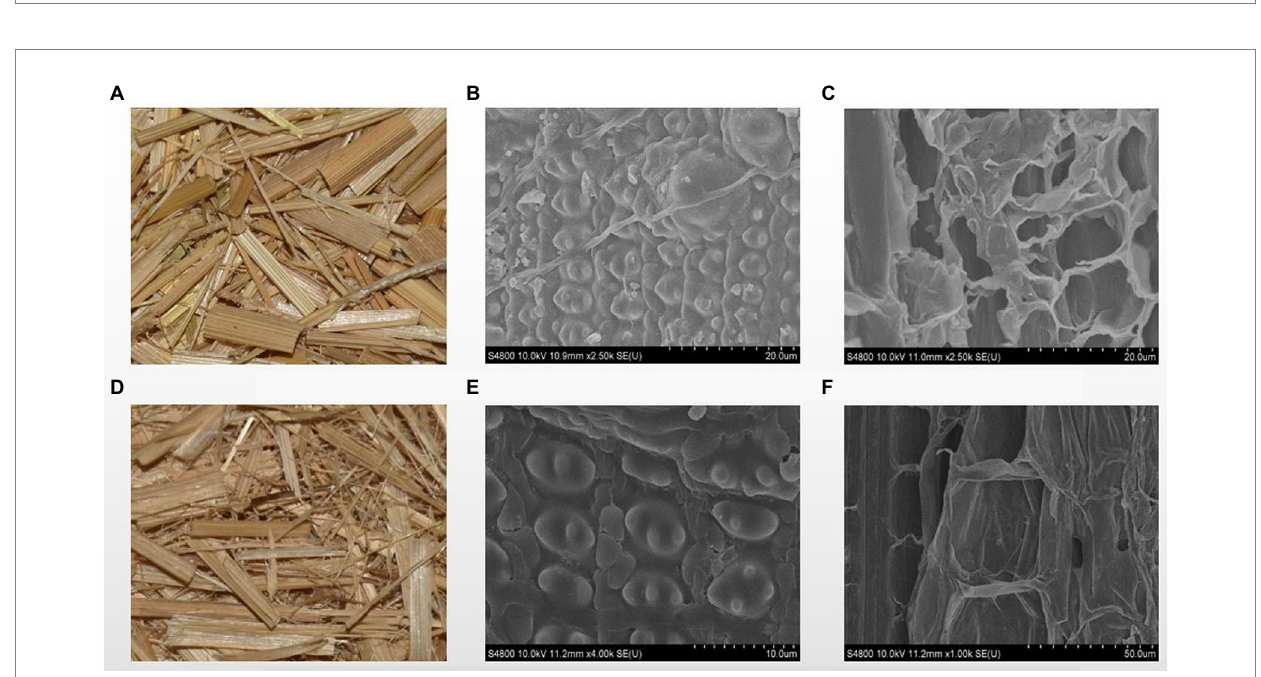
FIGURE 8 The SEM images of straw before and after treatment by ZJW-6. (A) straw before treatment; (B) the outer surface of straw before treatment; (C) the internal structure of straw before treatment; (D) straw after treatment; (E) the outer surface of straw after treatment; (F) internal structure of straw after